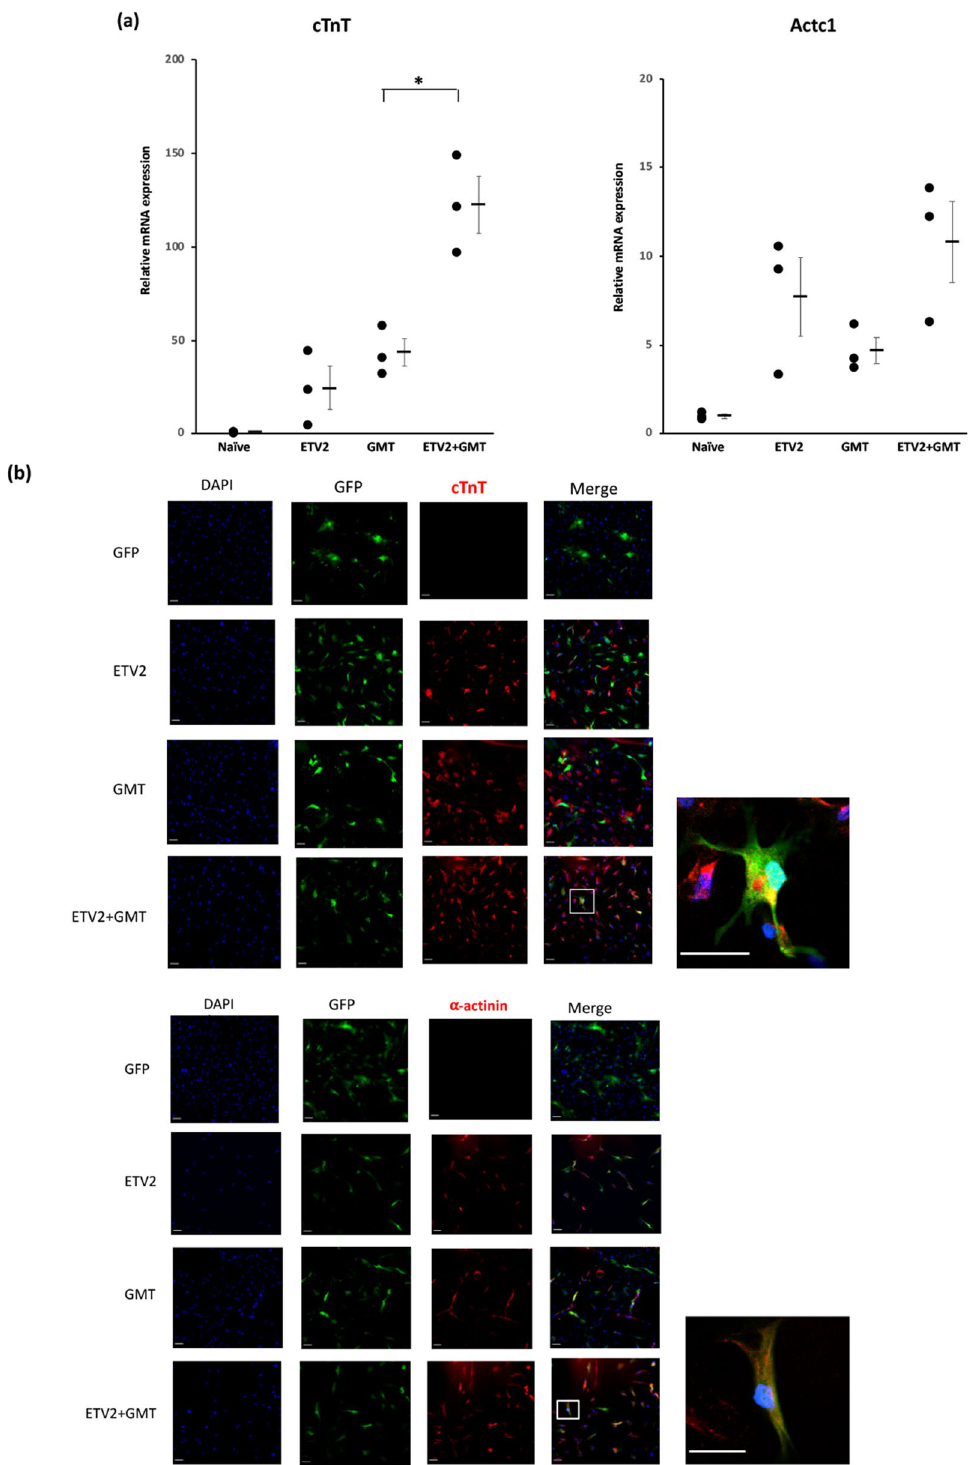
Figure 4. ETV2 induction prior to GMT treatment enhances the reprogramming of human cardiac fibroblasts into cardiomyocyte-like cells. Human cardiac fibroblasts were treated with doxycycline with or without administration of lentivirus encoding ETV2 and rtTA. Three days after doxycycline withdrawal, cells were treated for 14 days with lentivirus encoding GFP with or without GMT (n = 3). ( a ) qPCR analysis demonstrating increased expression of the cardiomyocyte markers cTnT (*p < 0.05) in ETV2 + GMT treated cardiac fibroblasts compared to cells treated with GMT alone. ( b ) Immunostaining demonstrating the increased prevalence of cTnT and α-actinin in cells treated with ETV2 + GMT compared to cells treated with GMT alone. High magnification views (× 100) are shown on the far right. Scale bar: 100